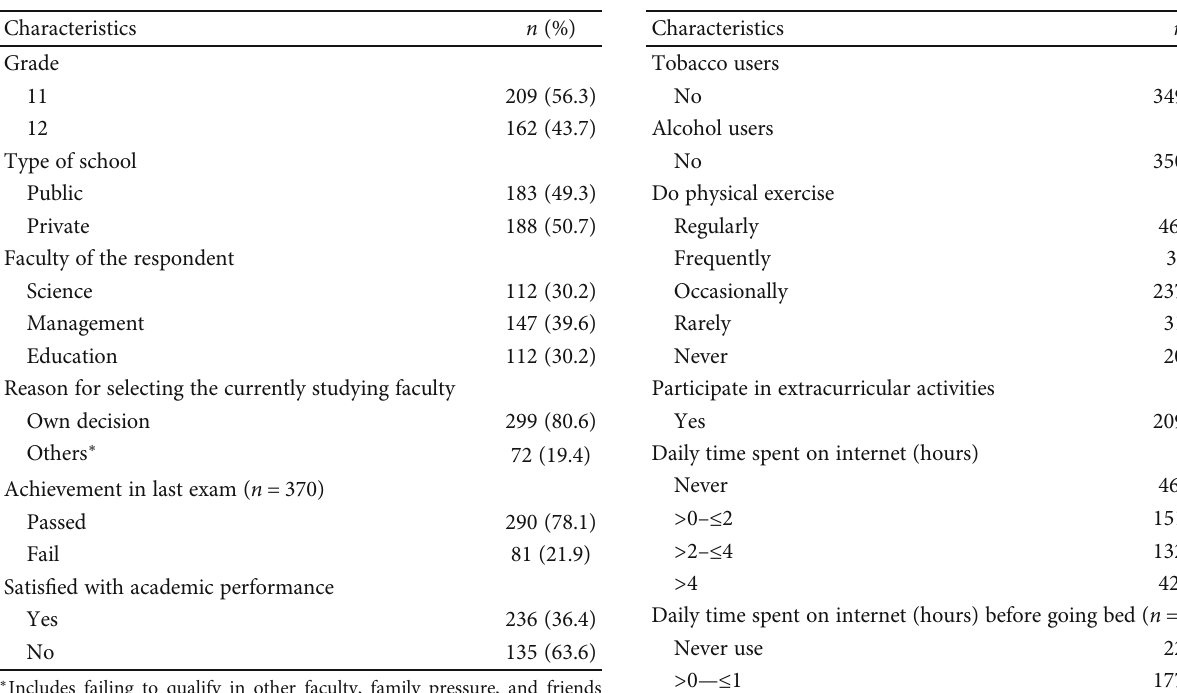
Table 4: Behavioural characteristics of respondents ( n = 371